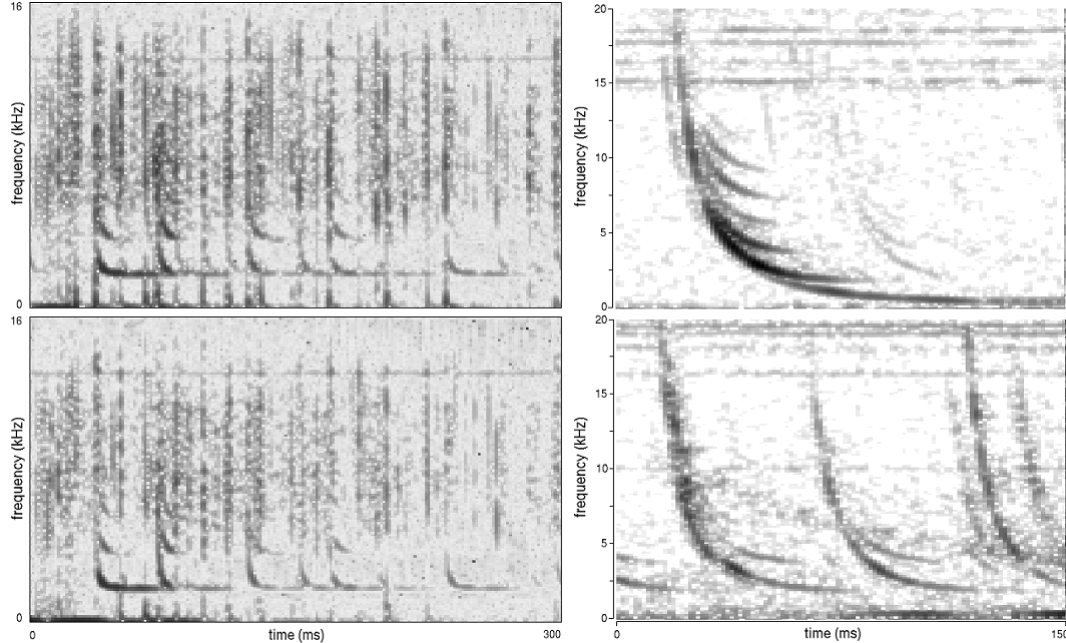
Fig. 11. Tweeks (left column) in a ground-based, crossed loop VLF recording (Marion Island, 28 April 2001, 03:15:25 UT, with permisson of A. R. W. Hughes, Durban, South Africa) and examples of SpWs (DEMETER VLF ICE, right column) exhibiting similar mode